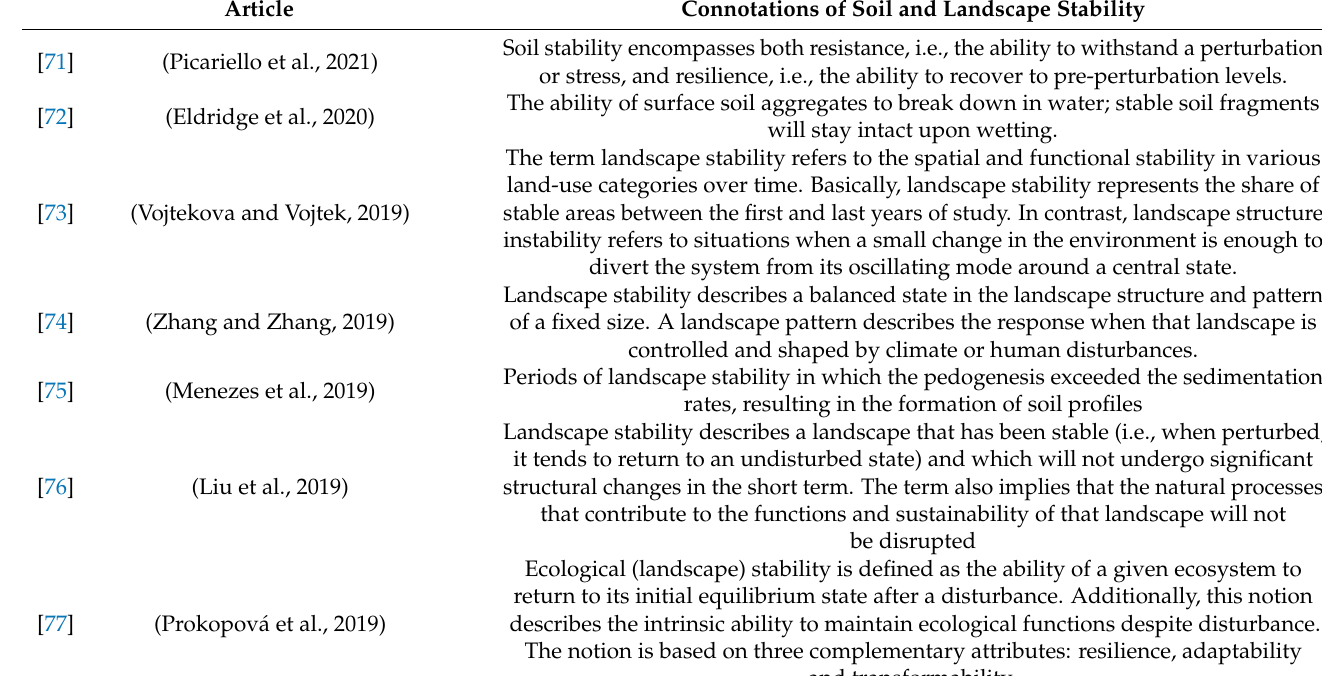
Table 6. Connotations of soil and landscape stability, ordered reverse